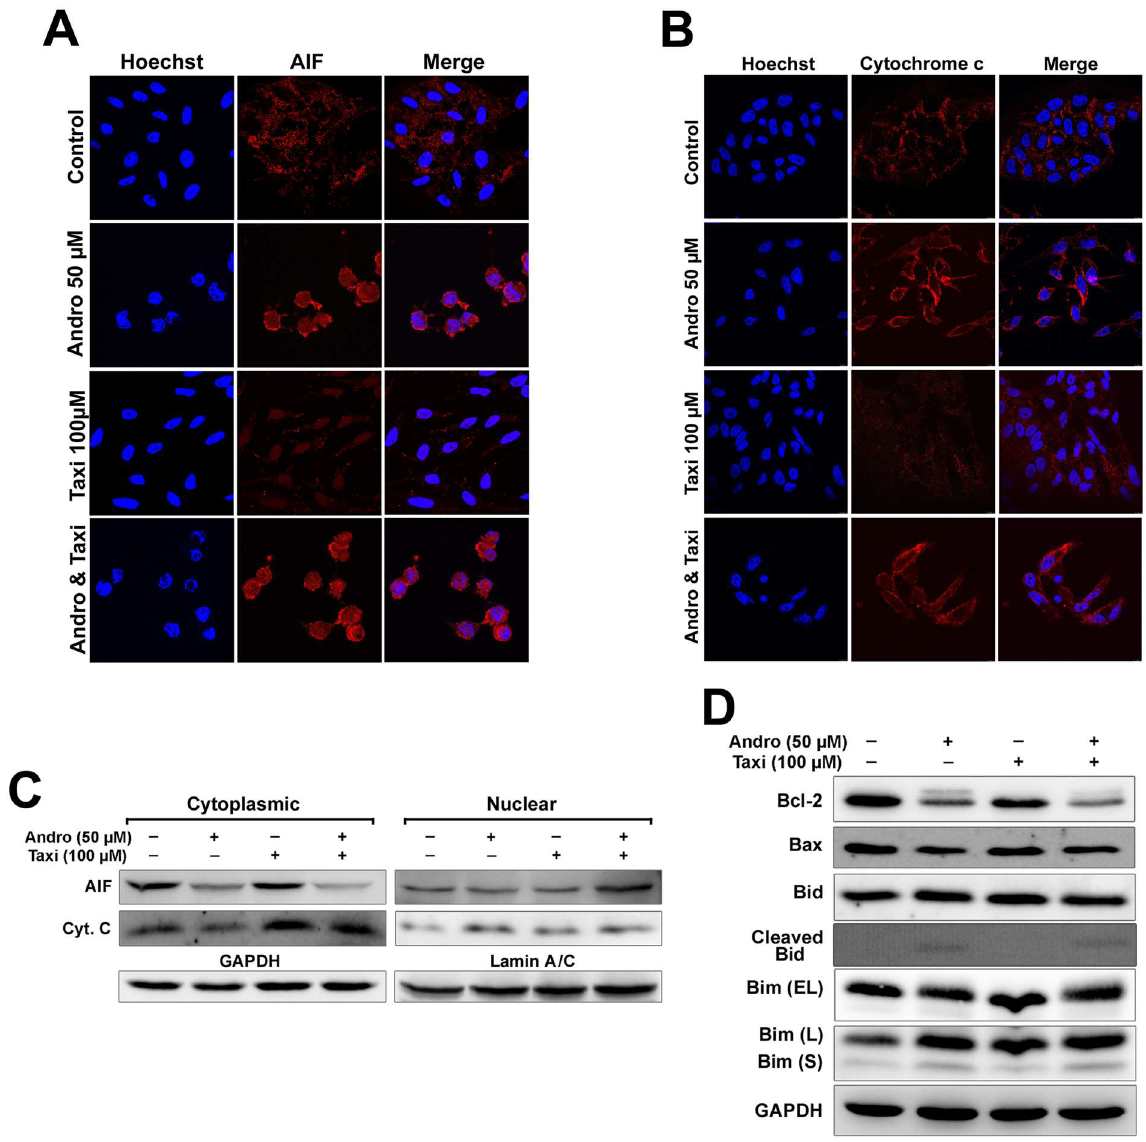
Fig 7. Role of AIF, Cytochrome c and proapoptotic factors in the cell death induced by Andro and/or Taxi on Hela cells. (A & B) Effect of Andro and/or Taxi on translocation of AIF and cytochrome c to the nucleusin HeLa cells. Cells were seeded on sterile coverslips, treated with 50 μ M Andro and/or 100 μ M Taxi for 24 h, fixed and immunostained with anti-AIF or anti-cytochrome c antibody, CFL-conjugated secondaryantibody, counterstained with Hoechst 33342 and then observedunder the confocal microscope, scale bar = 20 μ m. (C) Effect of Andro and/or Taxi on the expressionof AIF and cytochrome c proteins. (D) Effect of Andro and/or Taxi on the expressionof Bcl-2 and the proapoptoticproteins. GAPDH was used to ensureequal protein loading. Results are representedas mean ± SD (n = 3). # indicatessignificantly different (#, p <